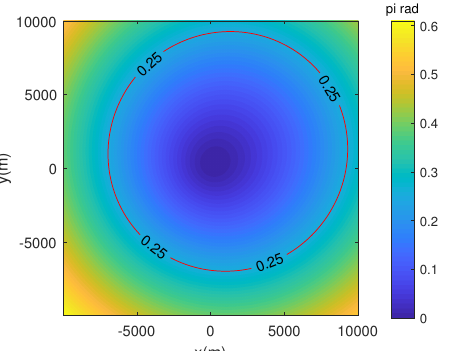
Figure 9. The residual higher-order phase of the imaging area. Table 3. Measured imaging metrics of the nine point targets by the ‘non-stop-and-go’ RMOSE. Target